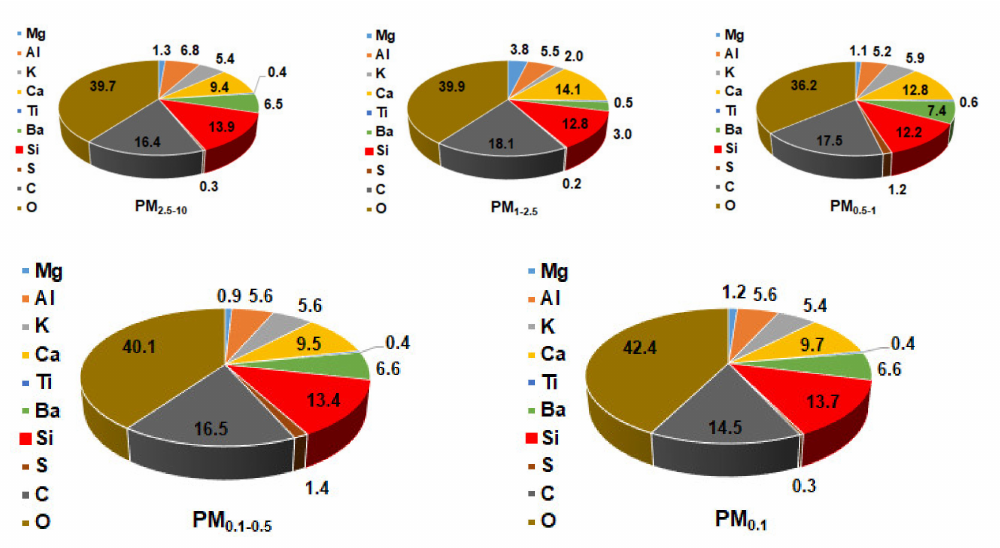
Figure 4. Elemental composition of indoor PM 2.5–10 , PM 1–2.5 , PM 0.5–1 , PM 0.1–1 , and PM 0.1 collected when the rooms were empty at S1.